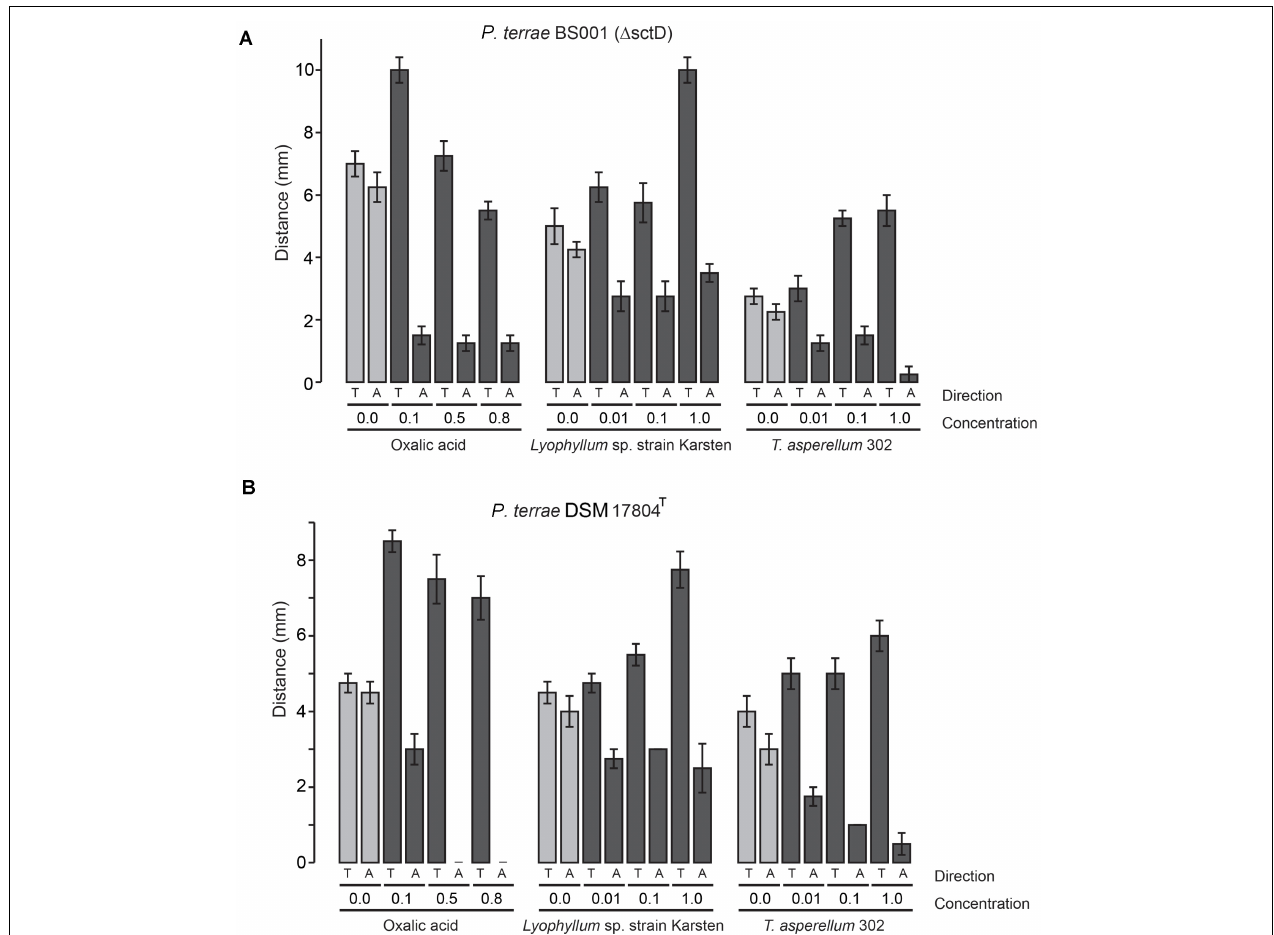
FIGURE 3 | Chemotactic (swimming) behavior of P. terrae strains BS001- (cid:49) sctD and DSM 17804 T toward oxalate and exudates of Lyophyllum sp. strain Karsten and T. asperellum 302 on 0.25% (w/v) M9 medium. (A) The response of P. terrae BS001- (cid:49) sctD to either oxalate or exudates of both fungal strains. (B) The response of P. terrae DSM 17804 T to either oxalate or exudates of both fungal strains The Y -axis represents the distance in mm, whereas the X -axis shows the direction of taxis (toward denoted by “T” and away denoted by “A”) and concentration of oxalate or levels of exudates. Data are representative of four biological replicates.